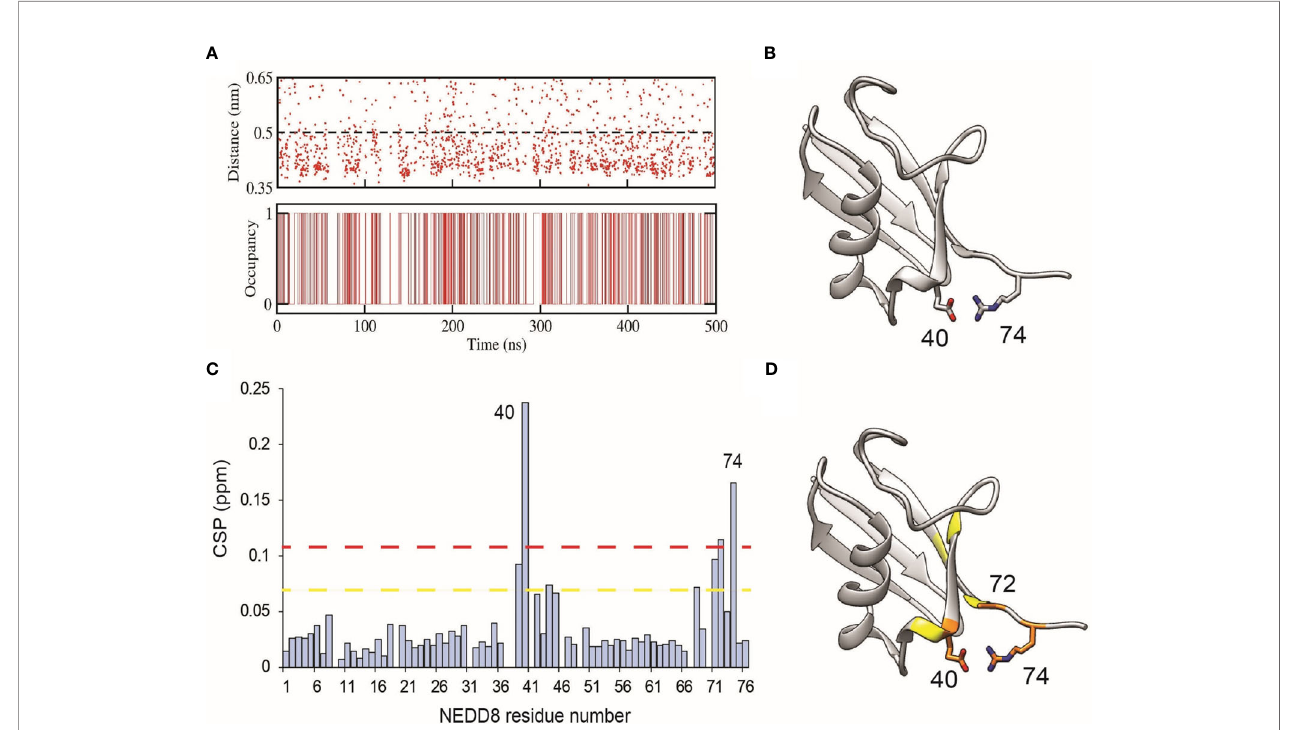
FIGURE 5 | Formation of an intramolecular salt-bridge in dNEDD8. (A) Salt-bridge stability as a function of time in a 500 ns MD simulation of dNEDD8. In the bottom plot, salt-bridge occupancy is shown as either 1 or 0 to indicate the presence or absence of a salt-bridge, respectively. Salt-bridge occupancy was calculated using a 0.5 nm cutoff. The occupancy of the salt-bridge was calculated to be 44.2%. (B) MD snapshot showing the formation of R74-E40 salt-bridge in dNEDD8. (C) The NMR CSP plot showing the effect of Q40E substitution in NEDD8. The CSP = [( d H NEDD8 - d H dNEDD8 )2 + ( d N NEDD8 - d N dNEDD8 )2/25]1/2, where d H d H NEDD8 and dNEDD8 are amide proton chemical shifts of residue in wt-NEDD8 and dNEDD8, respectively. The dashed yellow line and red line denote Mean+SD and Mean+2*SD, respectively. (D) The residues with high CSPs are mapped onto the NEDD8 structure. The residues with CSP above Mean+SD are colored yellow, and the residues with CSP above Mean+2*SD are colored